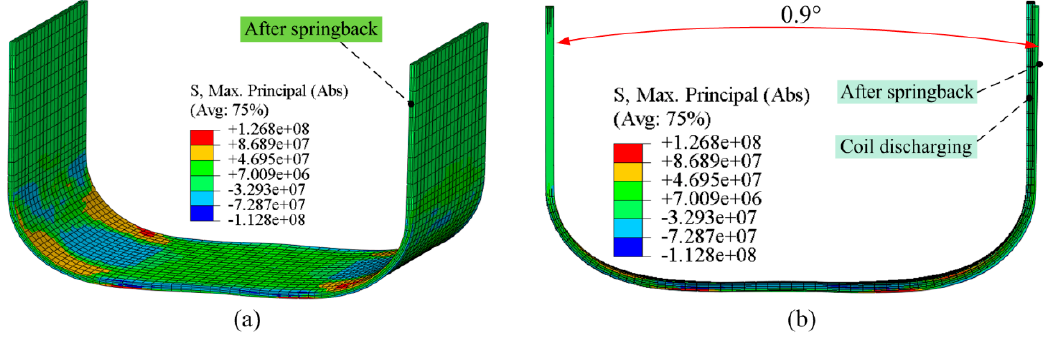
Figure 10. Springback after the coil discharge at 2 kV: ( a ) 3D view; ( b ) 2D view.